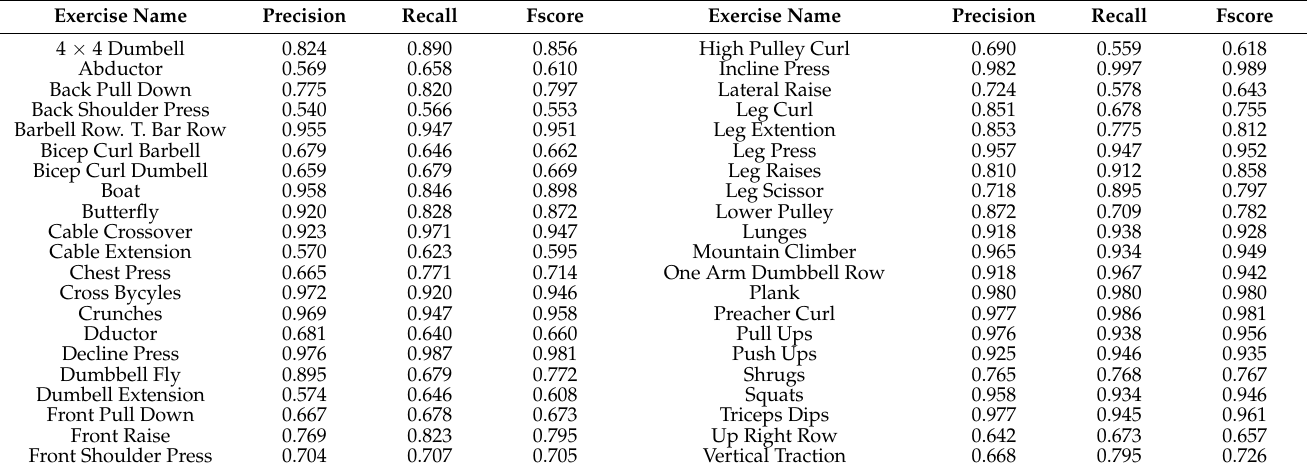
Table 6. Precision, recall, and F-score for the model covering all